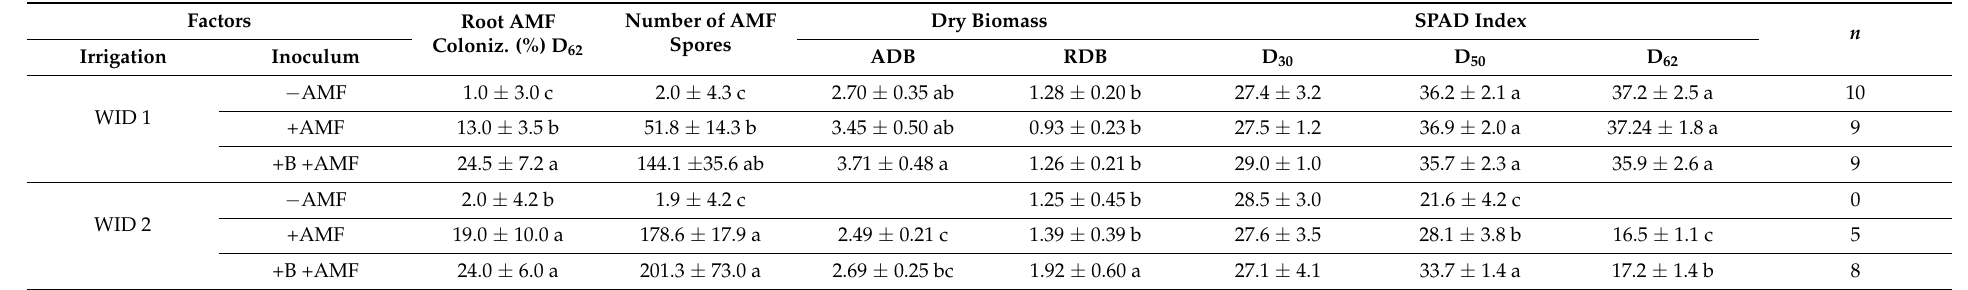
Table 5. Effects of AMF inoculum addition on AMF measurements, dry biomass and the SPAD index in lettuce crop (WID1: 70–80% container capacity, WID2: 10% container capacity; − AMF: without inoculum, +AMF: with AMF inoculum, +B +AMF: with AMF inoculum obtained from a solid substrate with biochar; ADB: aerial dry biomass at the end of the experiment, RDB: root dry biomass at the end of the experiment; D 30,50,62 : days after sowing; n : number of living plants at the end of the